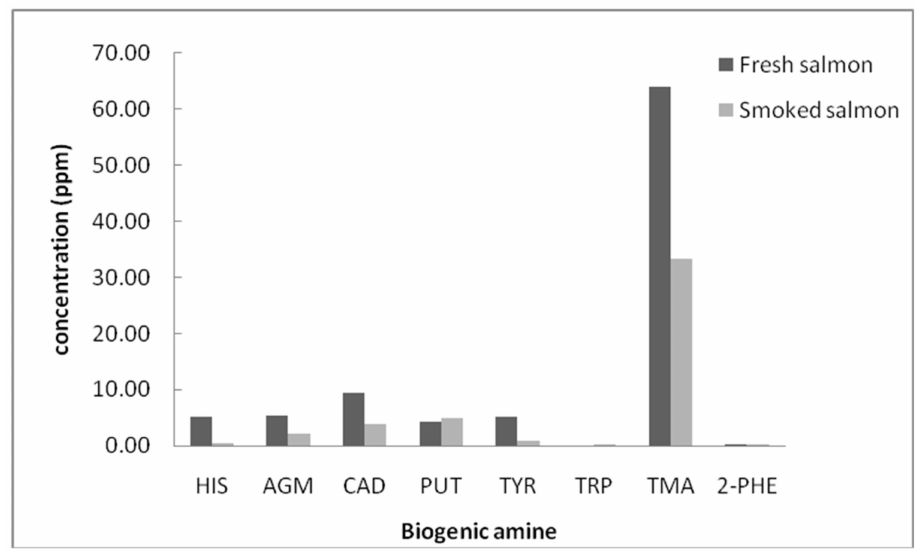
Figure 3. Concentrations of some biogenic amines in fresh and smoked salmon. HIS: Histamine, AGM: Agmatine, CAD: Cadaverine, PUT: Putrescine, TYR: Tyramine, TRP: Tryptamine, TMA: Trimethylamine, 2-PHE: 2-phenylethylamine